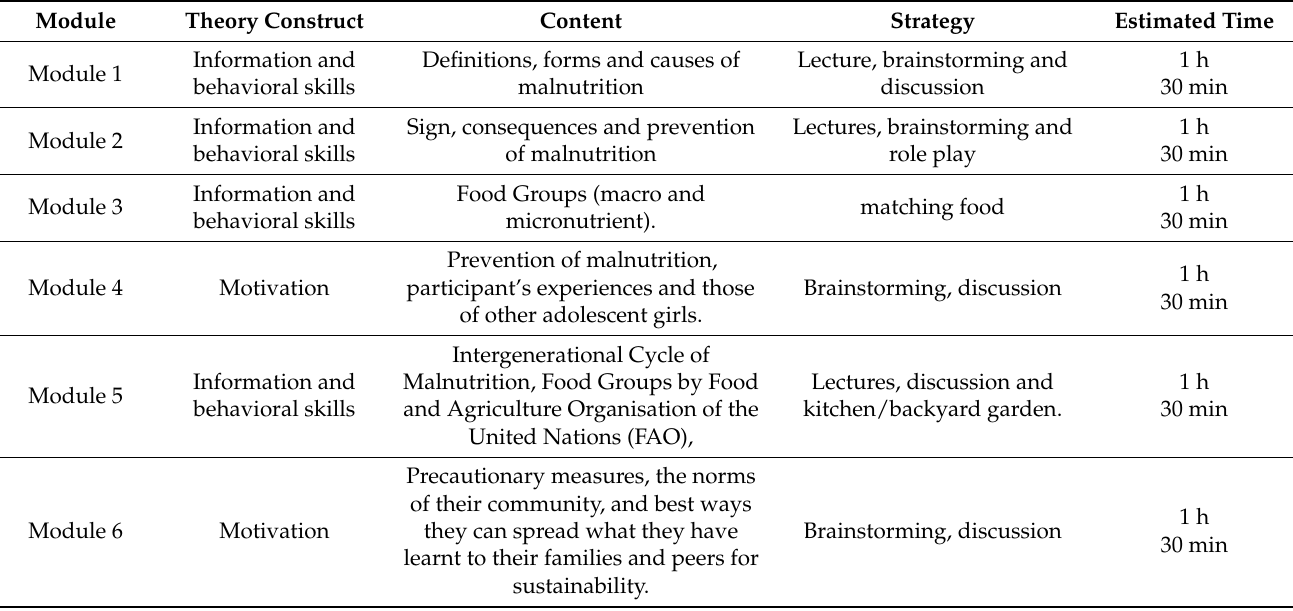
Table 1. Illustration of Triple Benefit Intervention Module using Information Motivation Behavioral Skill